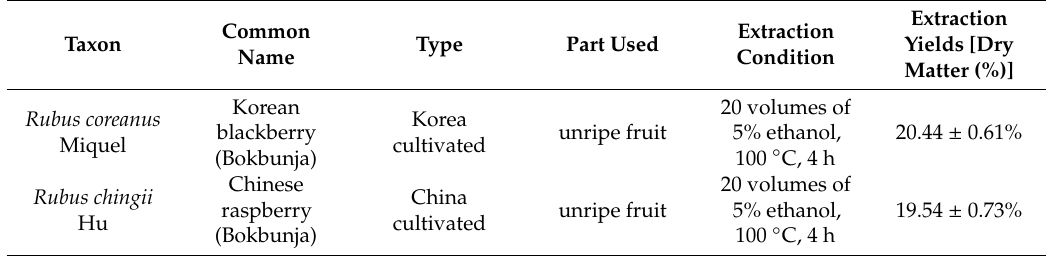
Table 1. Extraction yields of 5- u RCK and 5- u RCC under 5% ( v / v ) aqueous ethanol-extracted